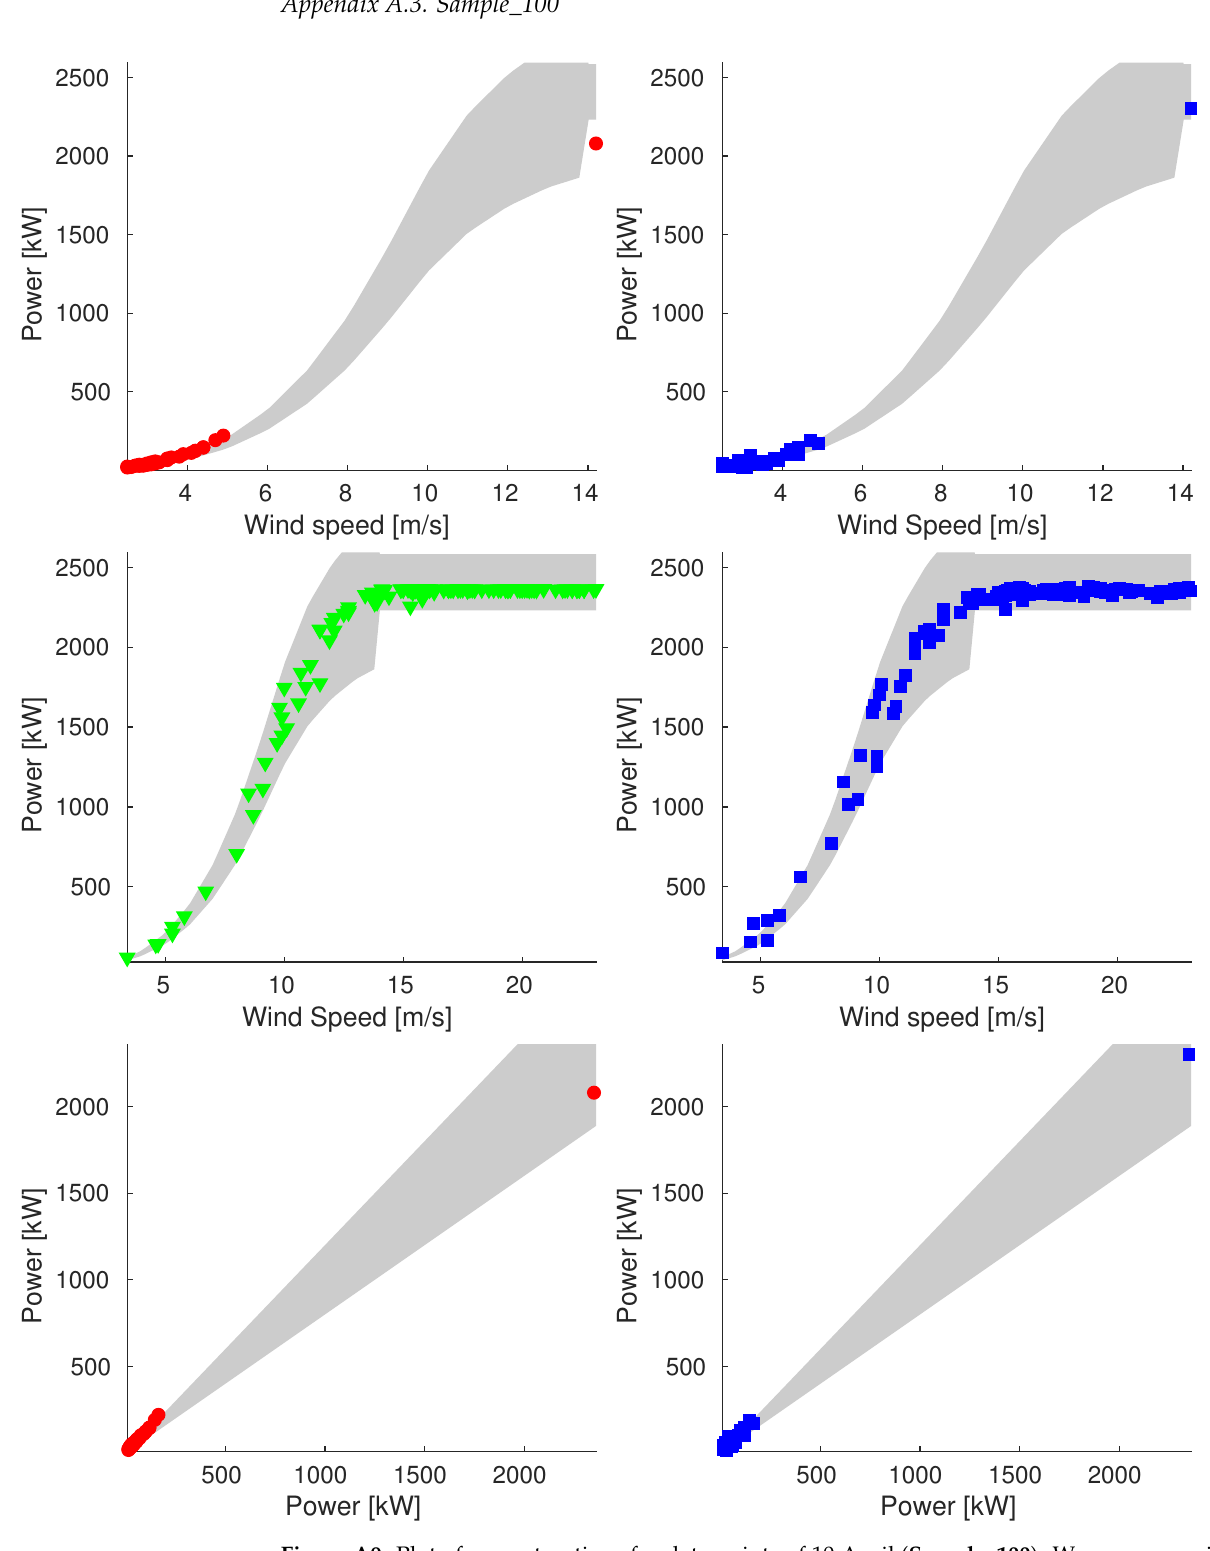
Figure A9. Plot of reconstructions for data points of 10 April ( Sample_100 ). We compare original data (on the left ) and reconstructed values (on the right ). We show plots of power vs.wind speed of rejected and validation data ( up and middle respectively) and plot of power vs.ideal power of rejected data ( bottom